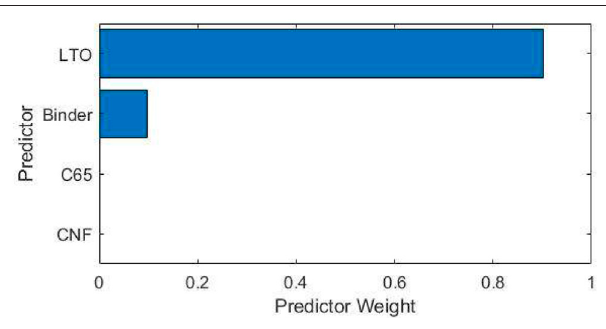
FIGURE 5 | Analysis of global effects of all four components.